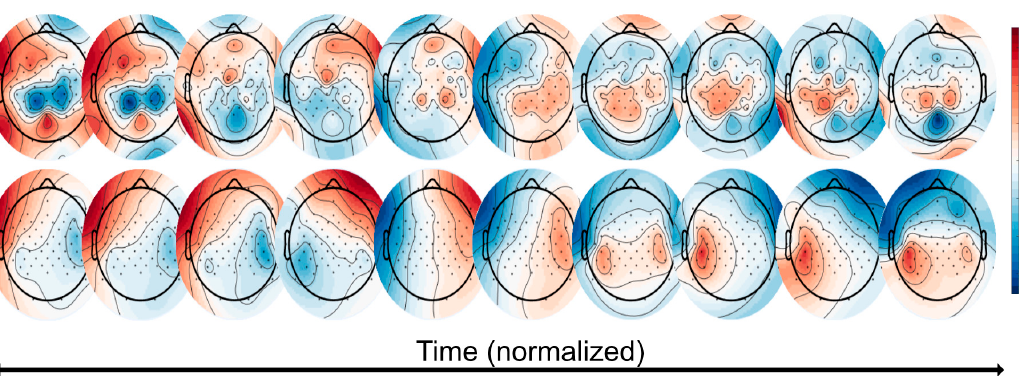
Figure 10. Classifier visualization of the TFA approach. ( Top ): these topographies represent the total ICA matrix multiplied with the first time bin of the TFA for the high beta frequency band. ( Bottom ): these topographies represent the further multiplication by the single task’s (here: ‘painting’) averaged covariance matrix. These topographies can be thought of as the ‘ideal’ topography over time that maximizes the ability to separate the task from others with respect to the classification weight vectors. This patient used the left